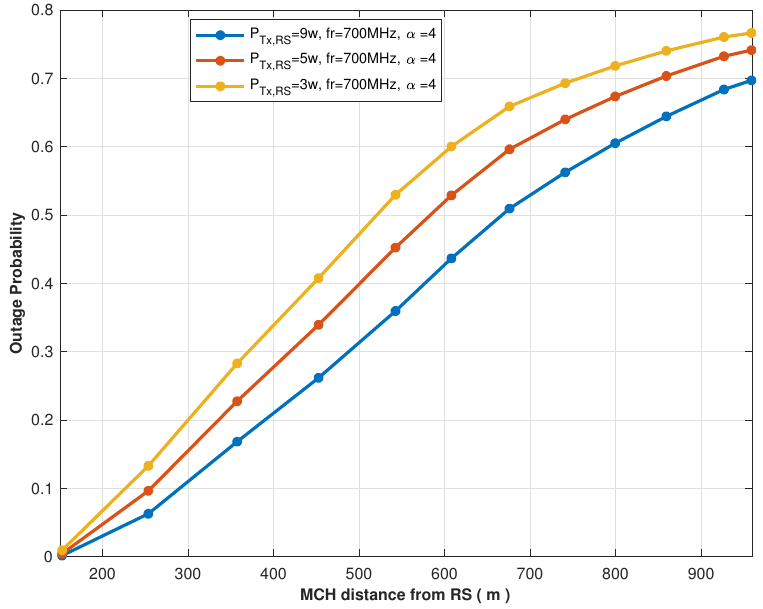
Figure 6. The outage probability vs. distance between MCHs and the optimal location of the RS when it transmits its signal by different